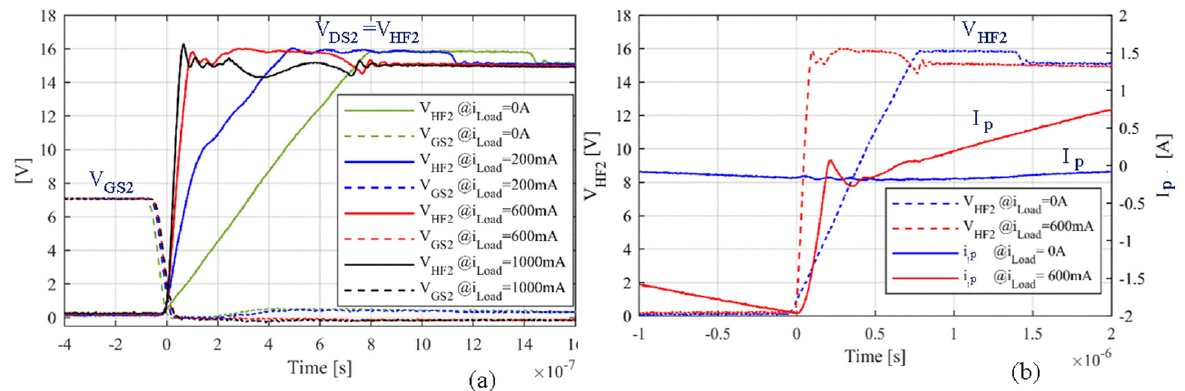
Figure 21. ( a ) Gate-source and drain-source switching transients of low-side device versus load current variation. ( b ) Primary-side current and drain-source voltage in two load current operative conditions.